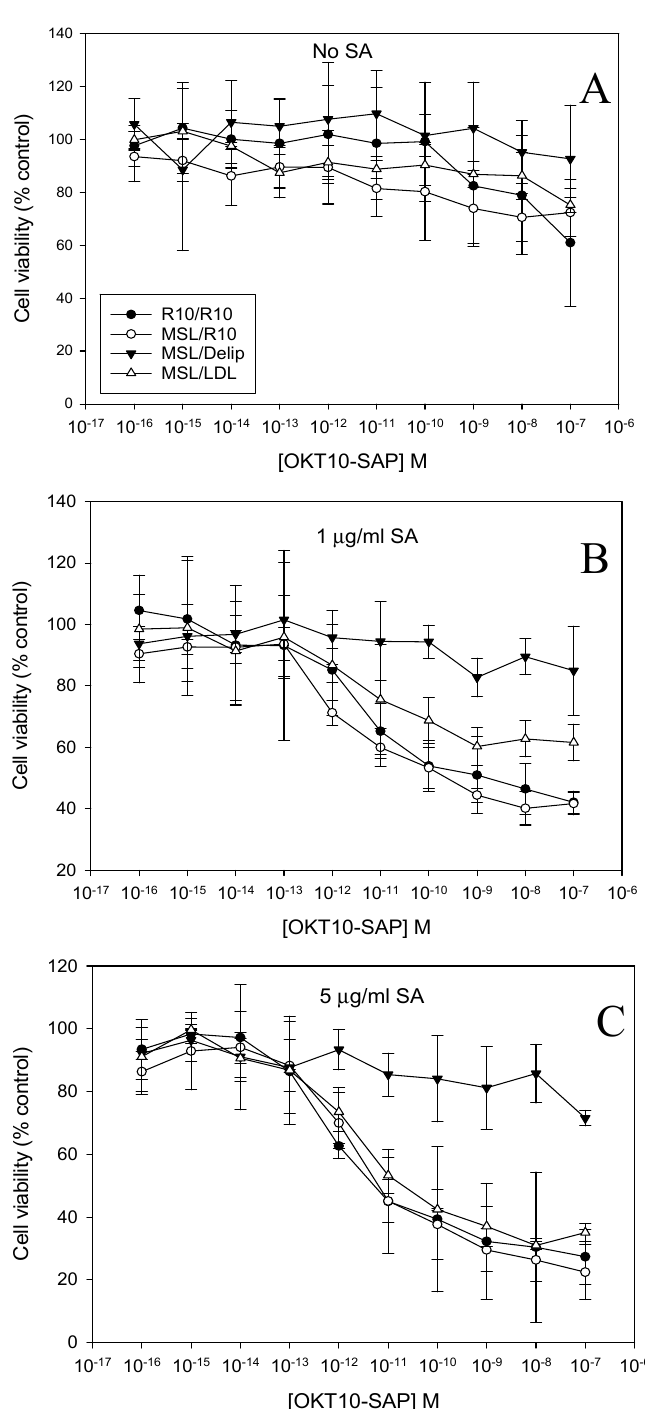
Figure 6. LDL repletion restores the SA augmentation of OKT10-SAP in the presence of SA. Dose–response curves obtained by XTT assay for lipid deprived cells ( ▼ ), lipid deprived cells repleted with LDL ( ∆ ) or R10 ( ○ ) compared to mock-treated control cells ( ● ) in the absence ( A ) or presence of 1 µ g / mL SA ( B ) or 5 µ g / mL SA ( C ). The data points presented are the mean of three independent experiments and the error bars represent one standard deviation either side of the mean.